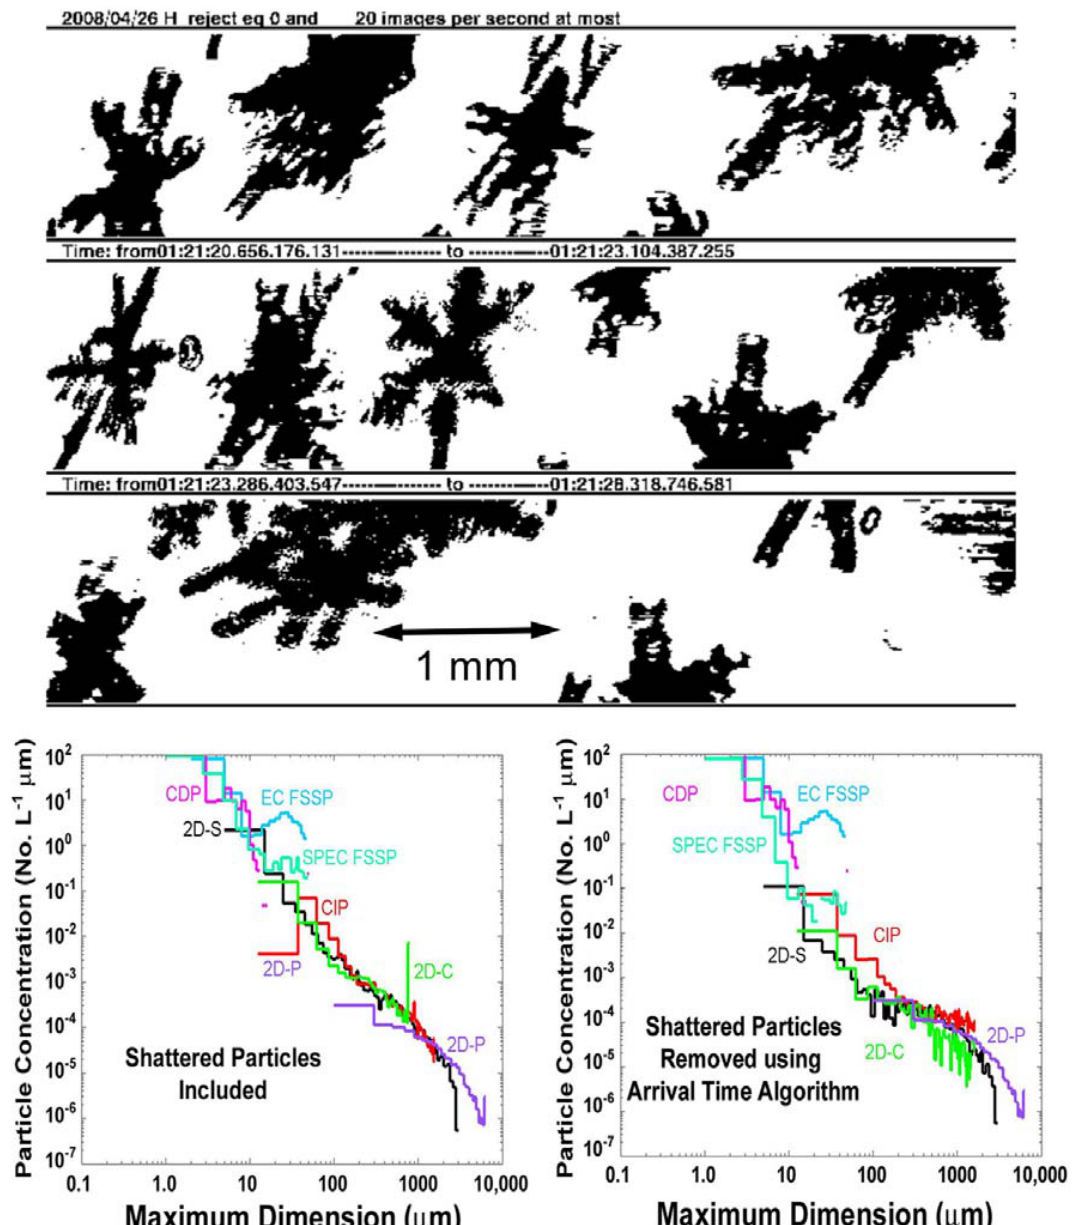
Figure 10. ( top ) 2D-S Images and (bottom) particle size distributions from several cloud Fig. 10. (top) 2D-S Images and (bottom) particle size distributions from several cloud particle probes flown on the Canadian Convair 580 particle probes flown on the Canadian Convair 580 in precipitating dendrites below cloud in precipitating dendrites below cloud base during ISDAC from 01:20:00 to 01:26:40UTC, 26 April 2008. Left panel shows measurements with shattered particles included and right panel with shattered particles removed using arrival time algorithm. EC FSSP=Environment Canada FSSP. CDP=DMT CDP. SPEC FSSP=SPEC Fast FSSP. CIP=DMT CIP. 2DC=EC 2DC. 2DP=EC. makes a significant contribution to total particle concentra- tion, whereas this is not the case when the natural ice con- centration is